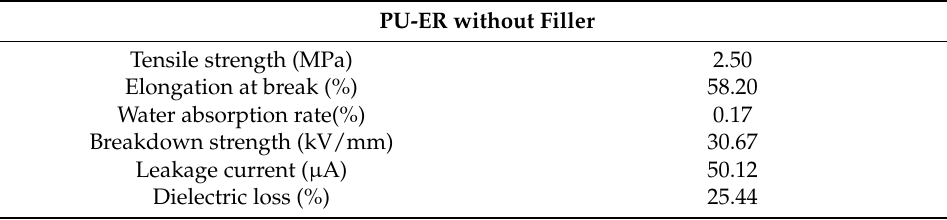
Table A1. Performance test results of PU-ER without